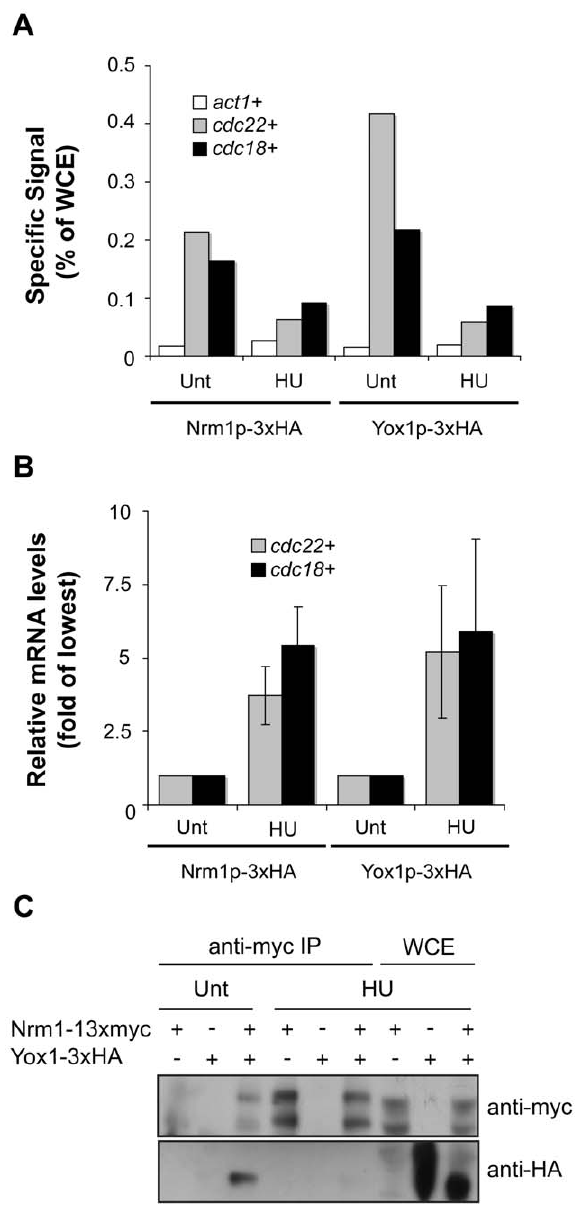
Figure 3. Yox1p is unable to bind and repress transcription in response to DNA replication stress. (A) Promoter fragments from Nrm1p-HA and Yox1p-HA ChIPs were quantified using qPCR from untreated and HU treated cells. Bar graphs represent percentage of WCE signal. Data representative of multiple independent experiments (see Figure S2 for a biological repeat experiment). (B) RT qPCR analysis on RNA isolated levels from untreated and HU-treated cells before cross-linking, are shown as fold of lowest relative levels detected. Error bars represent the SD of three independent biological repeats. (C) SDS PAGE analysis of anti-HA and anti-myc IPs and WCE for proteins deriving from same cells.